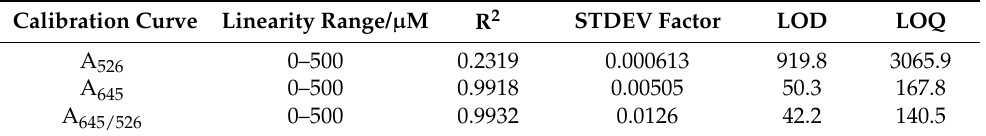
Table 1. The LOD and LOQ for NA using citrate-capped AuNPs. Calibration Curve Linearity Range/ µ M R 2 STDEV Factor